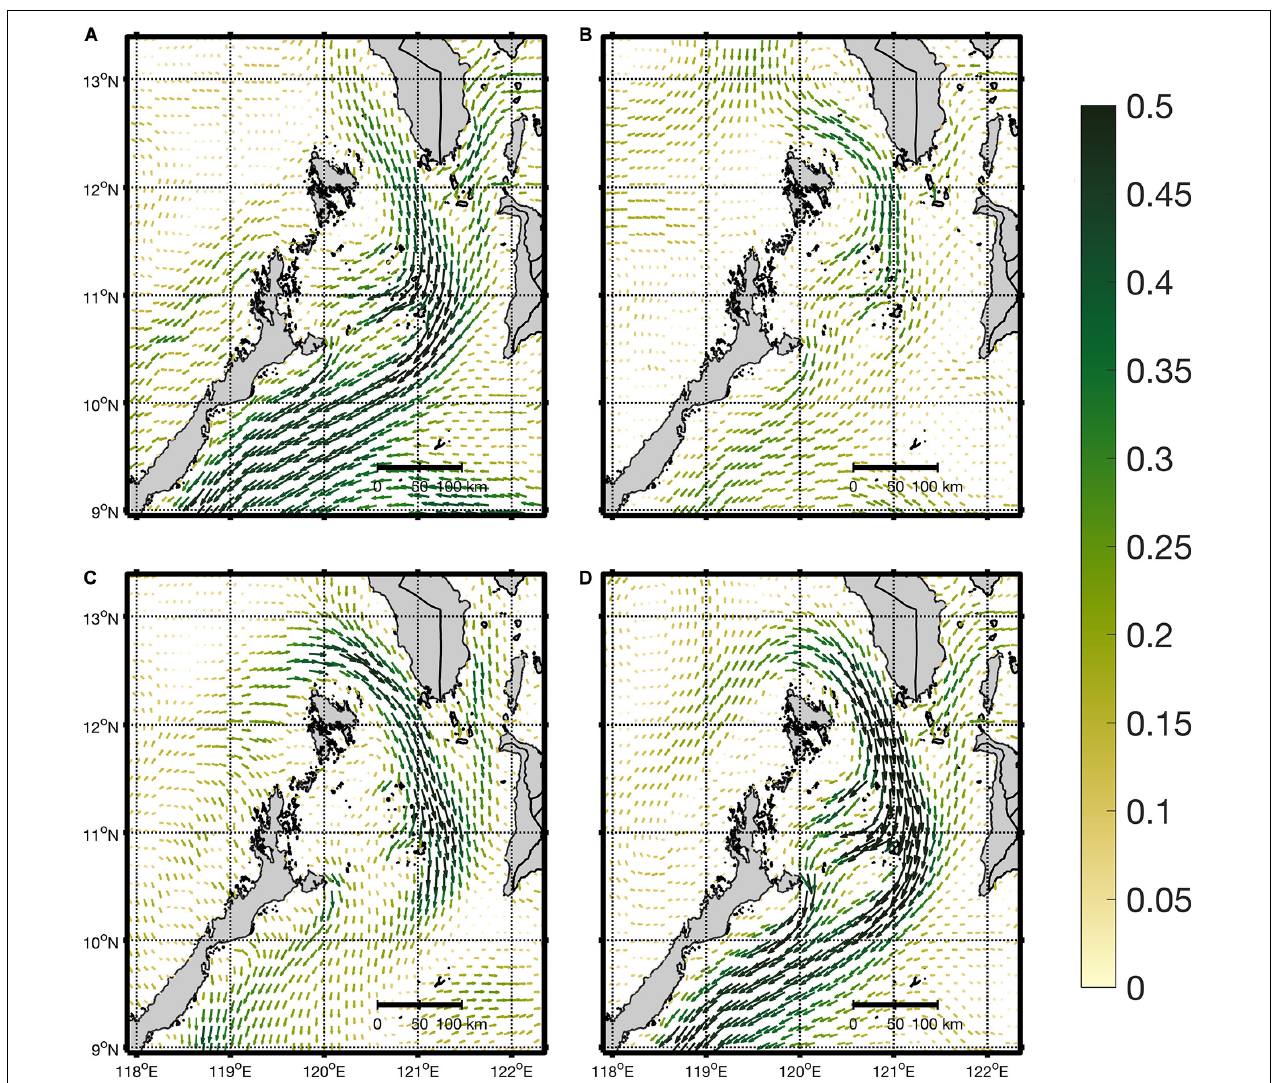
FIGURE 3 | Average surface currents per season: (A) NEM, (B) dry-transition, (C) SWM and (D) early NEM from the regional SEAc HYCOM model used for forcing the larval dispersal model. Color overlay represents current magnitude in ms - 1 and uses the colormap speed from the cmocean toolbox (Thyng et al., 2016).